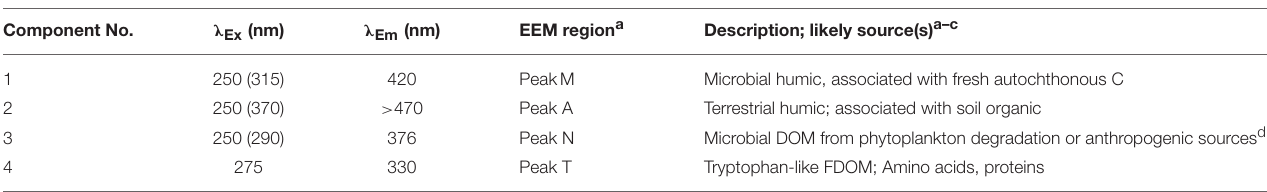
TABLE 2 | Fluorescence characteristics of Lake Erie